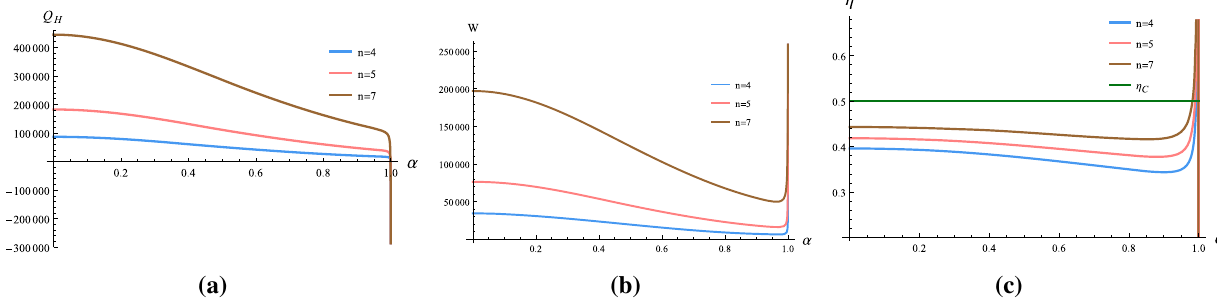
Fig. 14 In Einstein frame, plots for the net inflow of heat Q H , work done W and the efficiency η with respect to α (see the caption of Fig. 2 for parameter